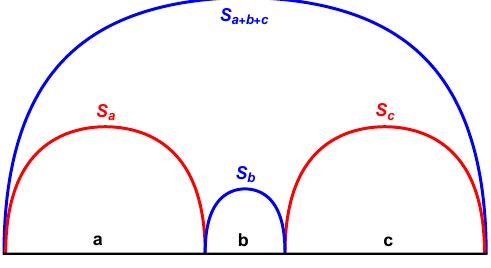
Figure 5 . The illustration of the holographic mutual